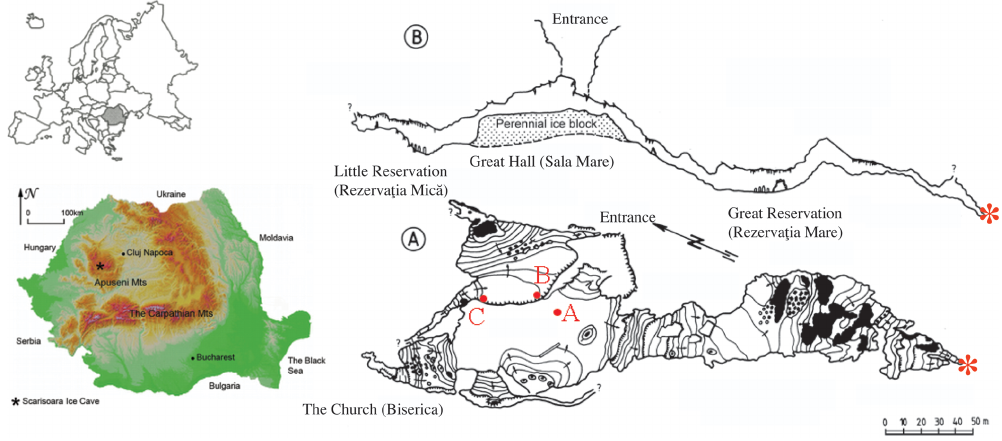
Fig. 1. Location map, plan view (A) and cross section (B) of Sc˘aris¸oara Ice Cave (modified from Rusu et al., 1970). The red points mark: (A) position of the cores drilled in 2005 and 2009, (B) position of SCL1, SCL2 and SCL 3 samples for radiocarbon dating, (C) position of SCL4, SCL5, SCL6, SCL7 and SCL 8 samples for radiocarbon dating. The red star marks the position of the collapse passage that was linking Sc˘aris¸oara Ice Cave and Pojarul Polit¸ei Cave (see main text for